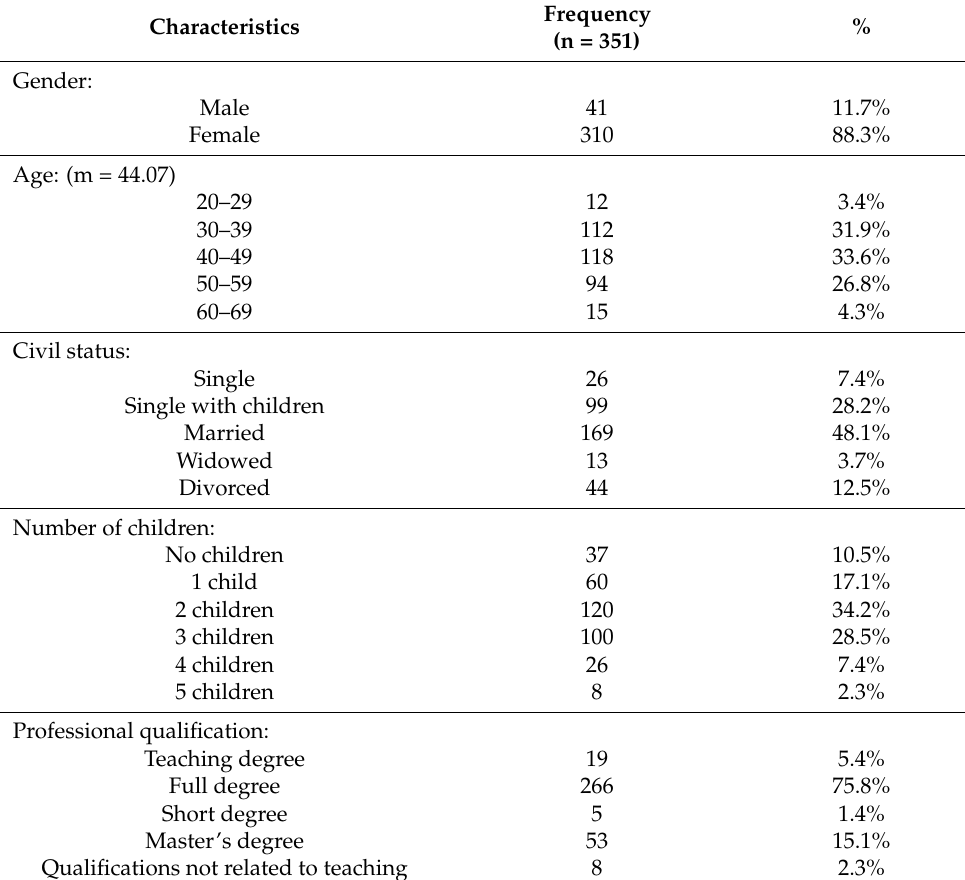
Table 1. Sociodemographic profile of the sample of infant and primary education